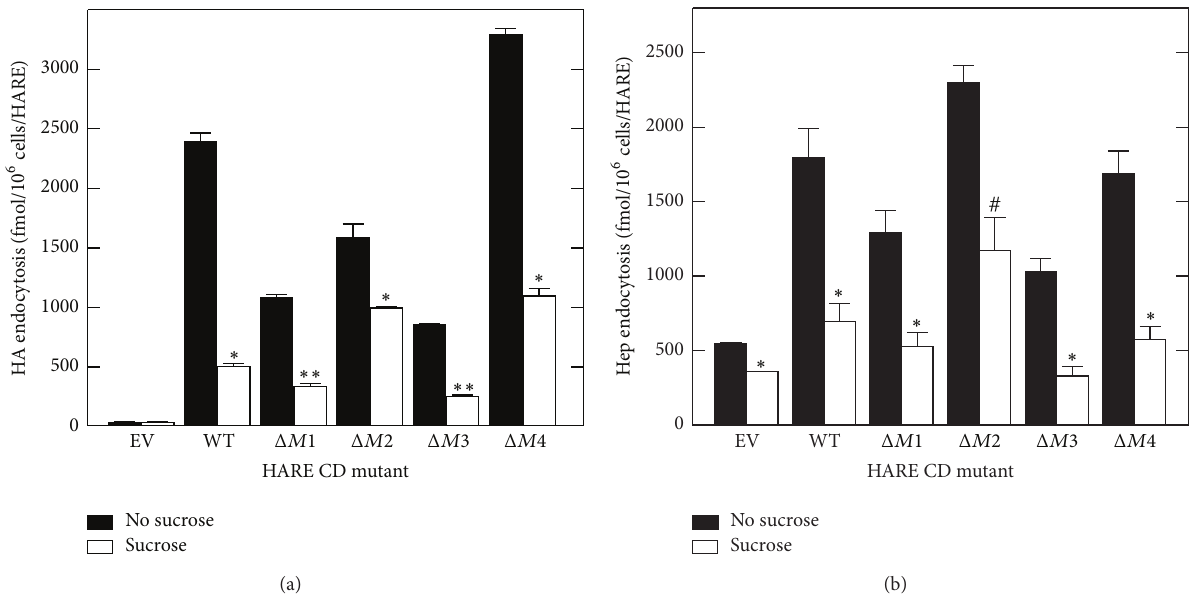
Figure 5: Endocytosis of HA and Hep by HARE CD variants is blocked by hyperosmolar conditions. Cells expressing EV, WT, or the indicated single-motif deletion HARE CD mutants were grown and pretreated as in Figure 2 and then preincubated at 37 ∘ C for 30 min with Endocytosis Medium with (white) or without (black) 0.45 M sucrose. The cells were then incubated with 125 I-labelled HA (a) or Hep (b) at 37 ∘ C for 4 h and processed as described in Methods section. Values are means ± SE ( 𝑛 = 6 ) and significant differences (assessed by Student’s 𝑡 -test) between control and sucrose-treated samples are indicated: # 𝑃 < 0.05 ; ∗ 𝑃 < 0.005 ; ∗∗ 𝑃 < 0.0005 .